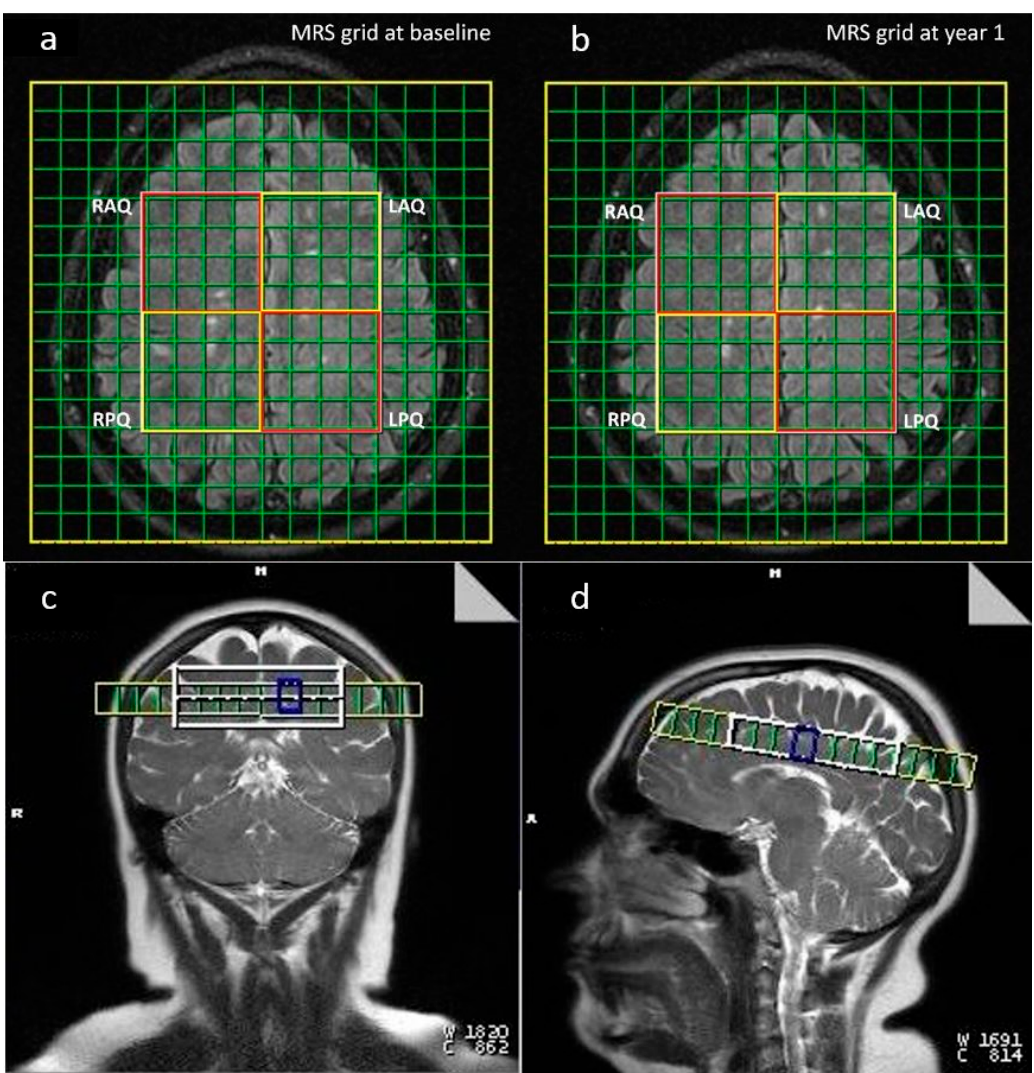
Figure 1. Axial View showing magnetic resonance spectroscopy (MRS) grid placed at same level at baseline and year 1 ( a , b ). Coronal and sagittal view of the MRS grid location in the periventricular area ( c , d ). RAQ—Right Anterior Quadrant, LAQ—Left Anterior Quadrant, RPQ—Right Posterior Quadrant, LPQ—Left Posterior Quadrant.